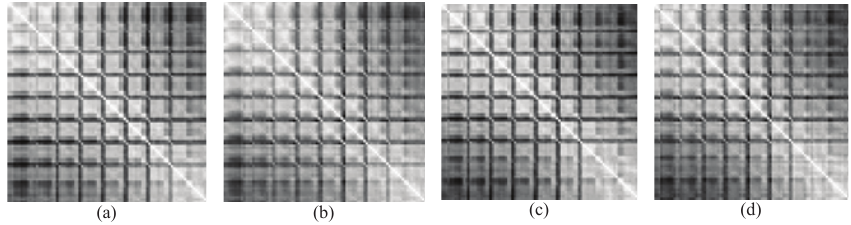
Figure 10. Quality index matrix derived from the quality indices for the cropped image obtained from (a) top-left (b) bottom-left (c) top-right and (d) bottom-right corners of the test image shown in gray-scale.